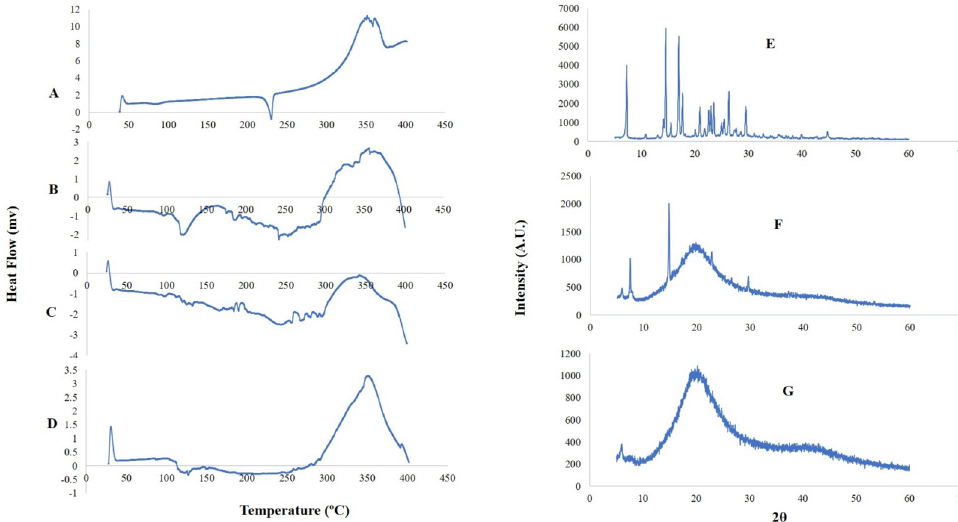
Fig 3. DSC thermogram of HT, PC, PM and